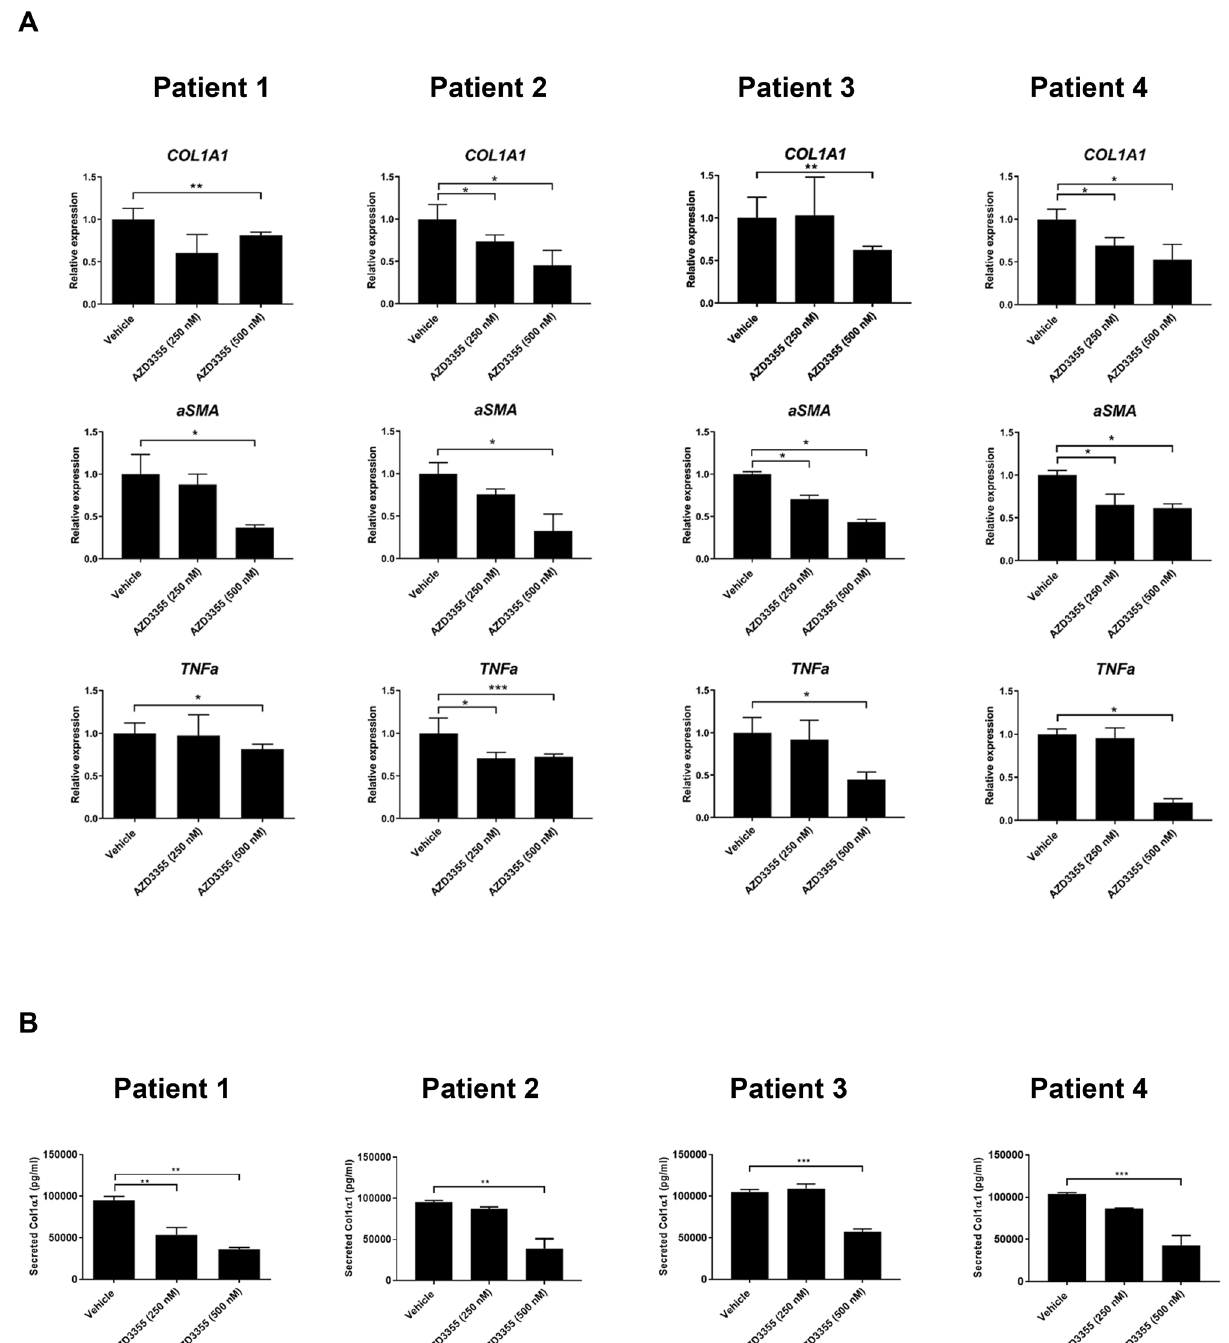
Figure 4. AZD3355 reduces fibrogenic and inflammatory gene expression as well as Col1α1 protein secretion in human liver slices. Precision cut human liver slices (hPCLS) from four different patient donor liver samples were cultured with either DMSO (as vehicle) or AZD3355 (250 and 500 nM) for 24 h. Quantitative PCR was used to measure mRNA expression for Col1A1 , aSMA and TNFa . Two liver slices (8 mm diameter each) were used for each patient/drug concentration. Col1A1 , aSMA and TNFa gene expression was significantly down- regulated by AZD3355 treatment in each patient samples ( A ). Secreted Col1α1 protein in culture media was significantly reduced compared to vehicle group by AZD3355 treatment in all four patient liver slices measured by ELISA ( B ). Results were expressed as means ± SEM (n = 3). * p < 0.05, ** p < 0.01, *** p <